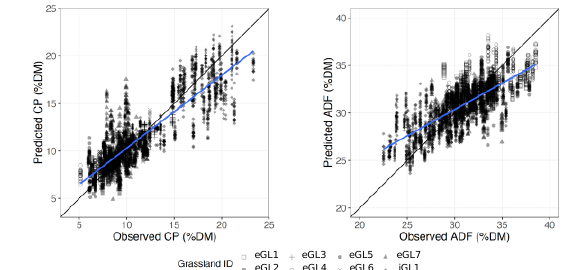
Figure 4: Observation vs prediction scatter plots from the resulting models for CP (left) and ADF (b) concentrations in different grasslands. Symbols represent different grasslands. The dashed line is the 1:1 line and the solid line represents the linear regression between observed and predicted values. Shown are 100 different model runs used in the model training and testing phase